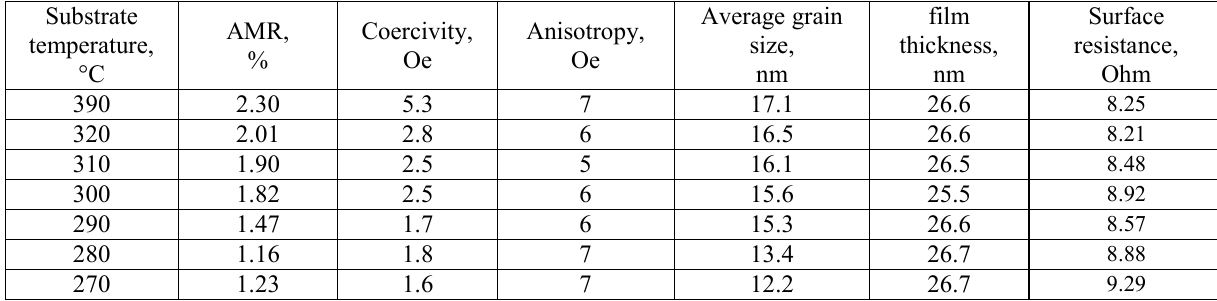
Table 2. The dependence of the parameters of the FeNi 20:80 permalloy film on the substrate temperature. Substrate